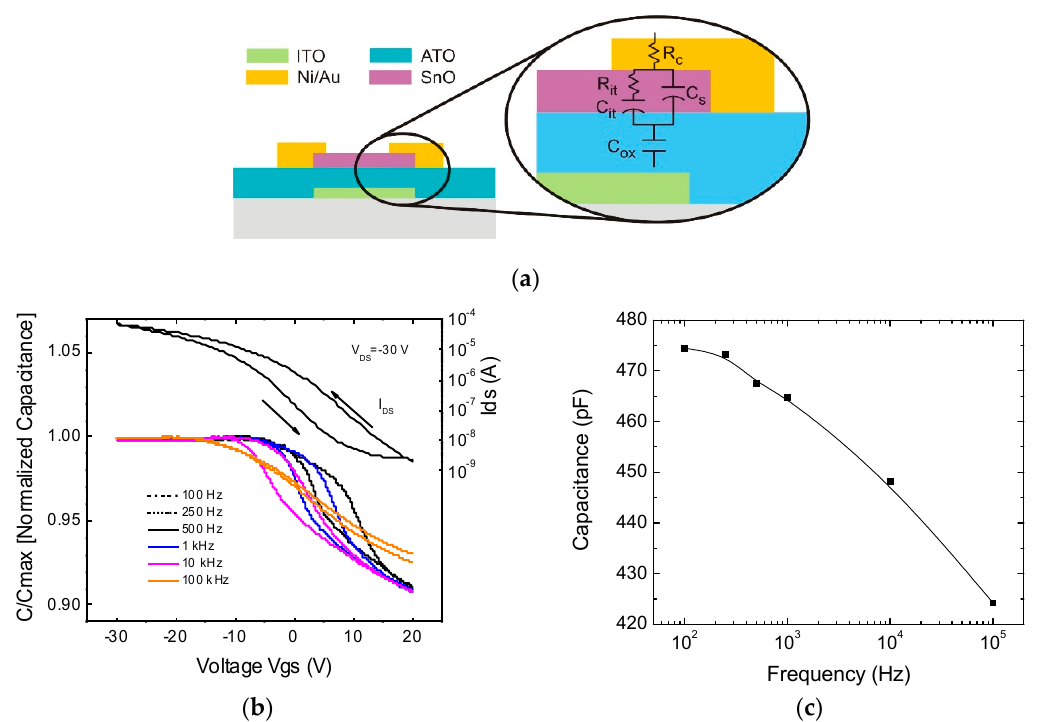
Figure 5. ( a ) Cross section sketch of the TFT, where t is also shown the equivalent electrical circuit based on RC resonators. ( b ) Normalized C ‐ V plot taken for different frequencies (below) and the IV transfer characteristic of the TFT (above); ( c ) Dependence of the maximum capacitance ( C max ) achieved on the frequency used.